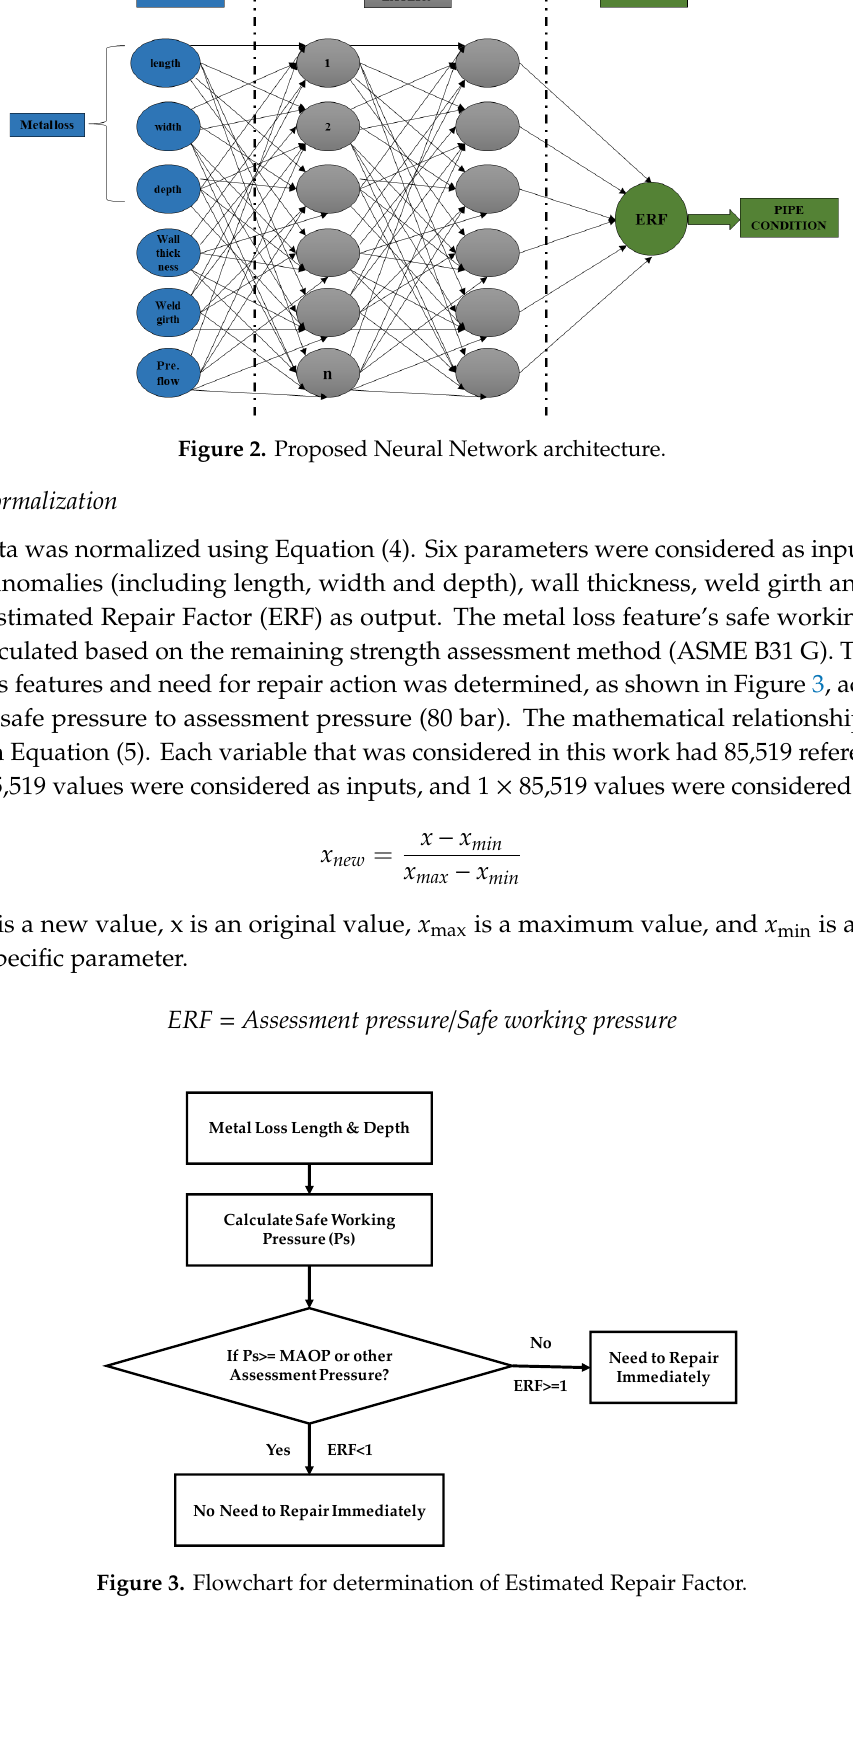
Figure 4. Proposed network architecture with functions.